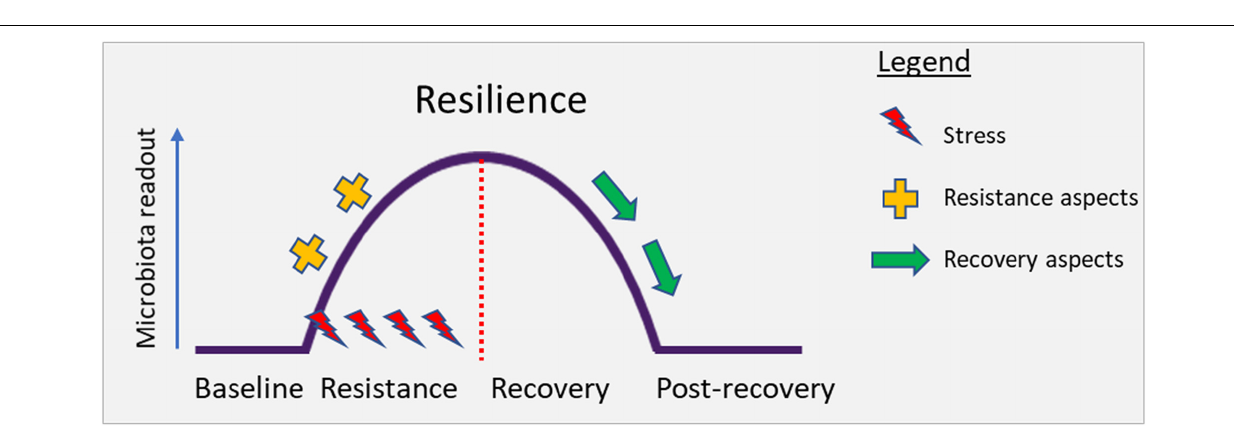
FIGURE 2 | Conceptual illustration depicting the perturbation of the gut microbiota under stress. Resilience describes the capacity of an ecosystem to maintain its state or recover from disturbances. Resilience is determined by the capacity to reduce the impact (resistance) and to recover from the impact of disturbance (recovery) (Ingrisch and Bahn,